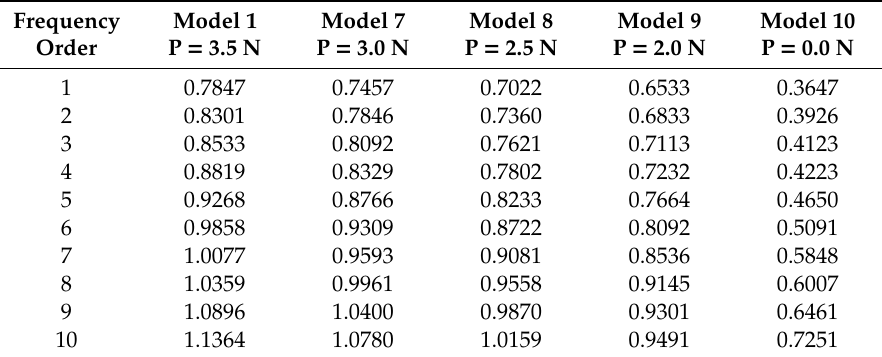
Table 7. Natural frequencies (Hz) of Mode 1, 7, 8, 9, and